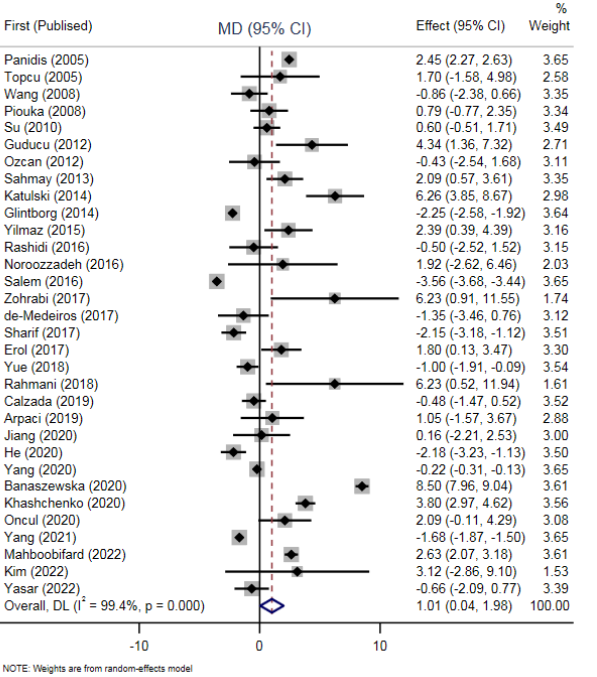
Figure 2. Meta-analysis of 32 comparisons reporting on PRL in PCOS participants compared with non-PCOS.